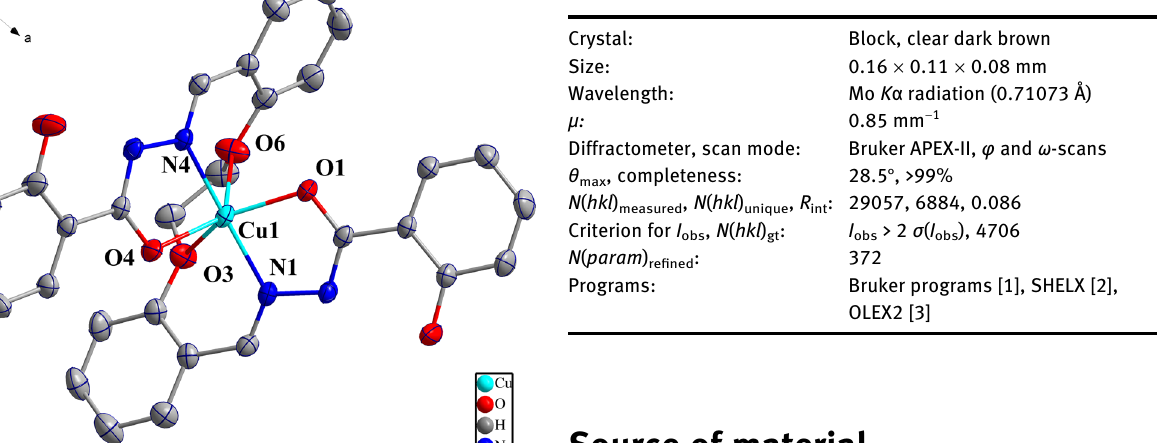
Table 1 contains crystallographic data and Table 2 contains the list of the atoms including atomic coordinates and displacement parameters.